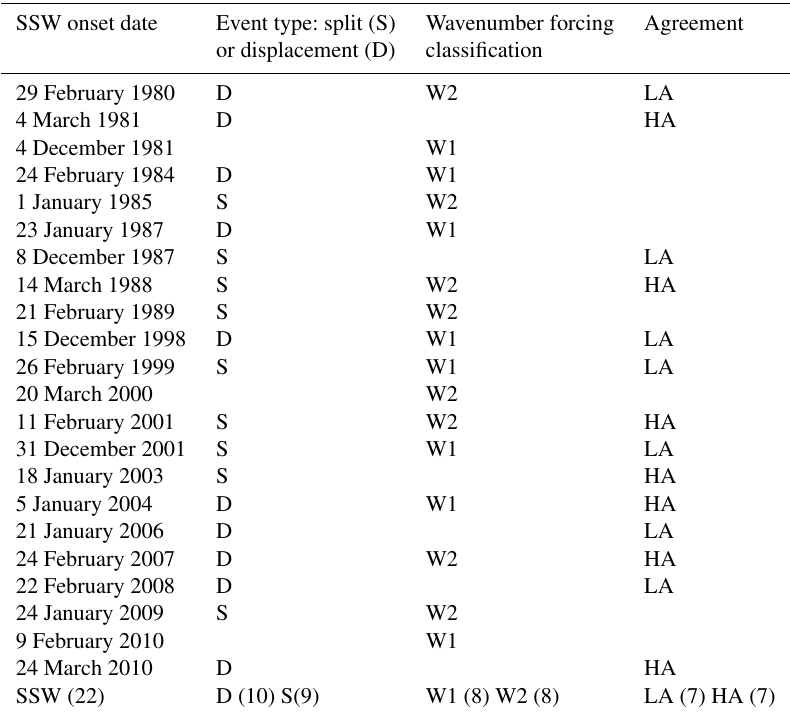
Table 2. Dates and types of SSW events used for the comparison. HA and LA denote high-agreement and low-agreement SSW events,